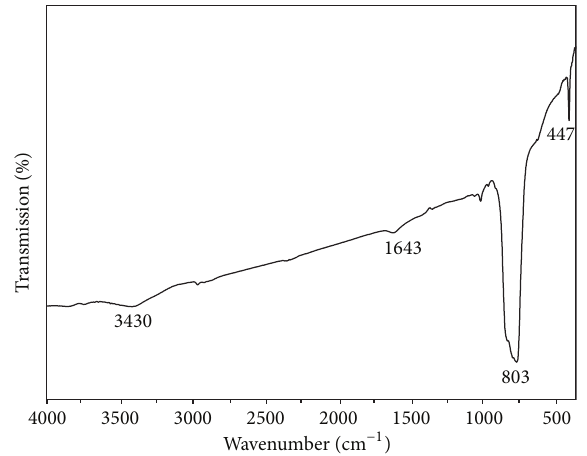
Figure 2: The FT-IR spectrum of SmVO 4 nanocrystals synthesized under 180 ∘ C, EDTA, pH =